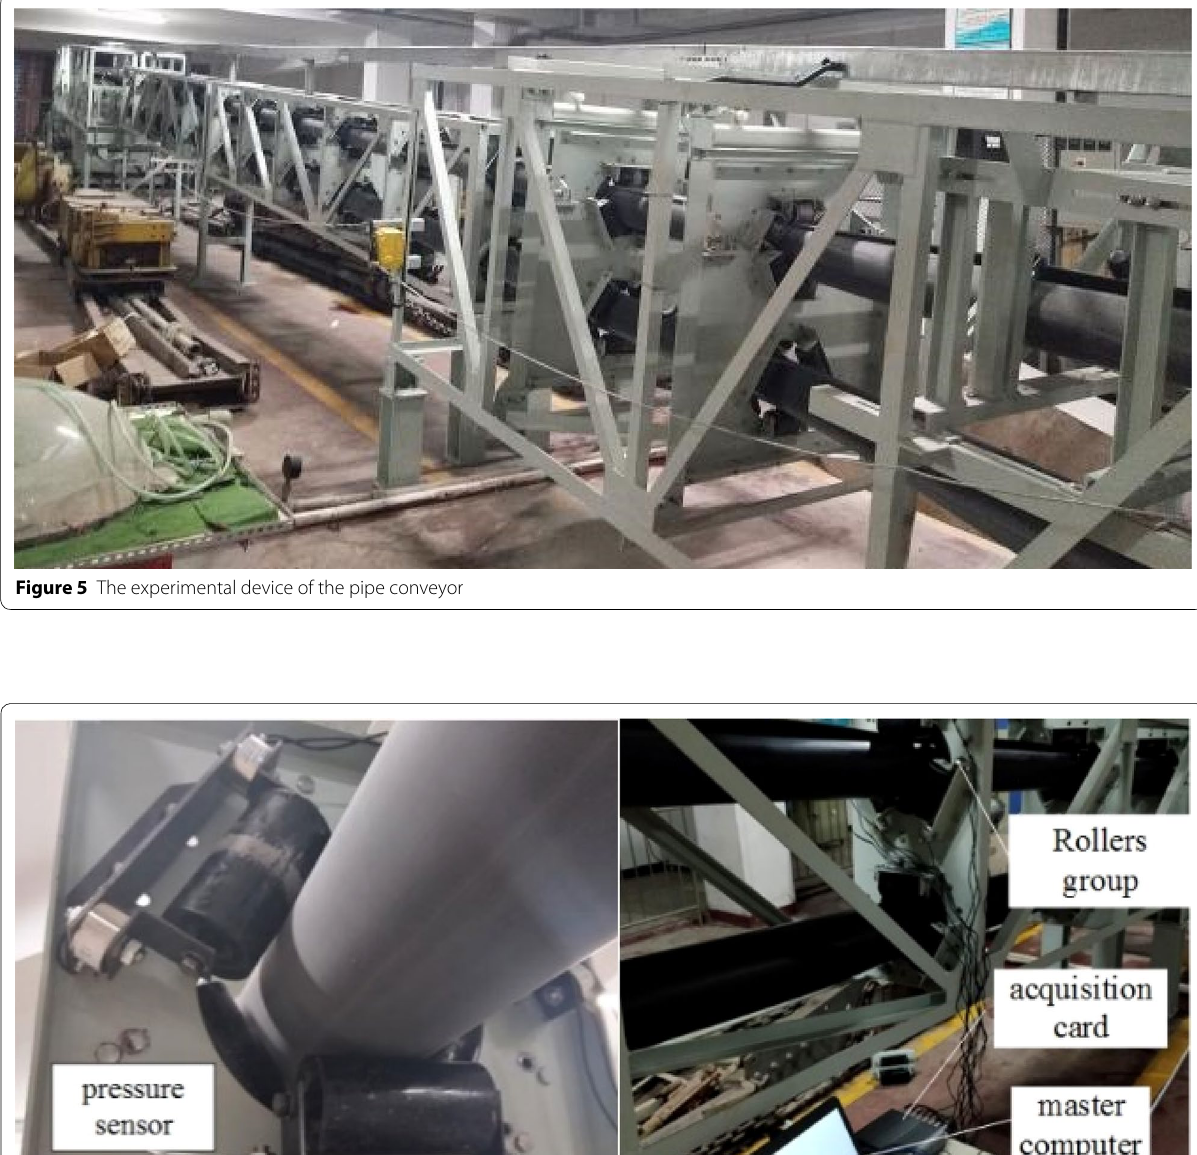
between the belt and the i th roller in the roller group. and x can be obtained when x [0.8, 1.6], that is =